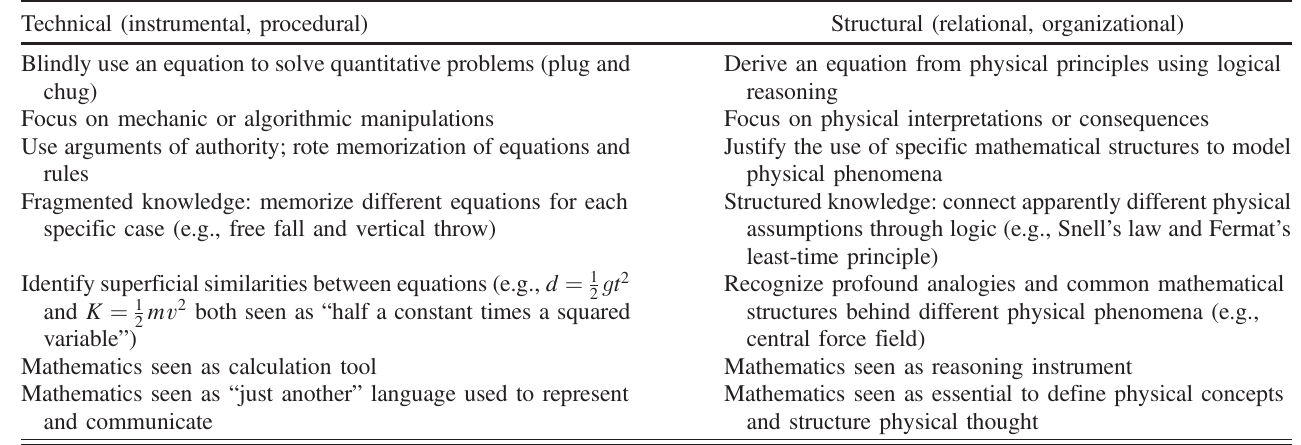
TABLE I. Technical-structural distinction concerning the role of mathematics in physics. Technical (instrumental, procedural) Blindly use an equation to solve quantitative problems (plug and